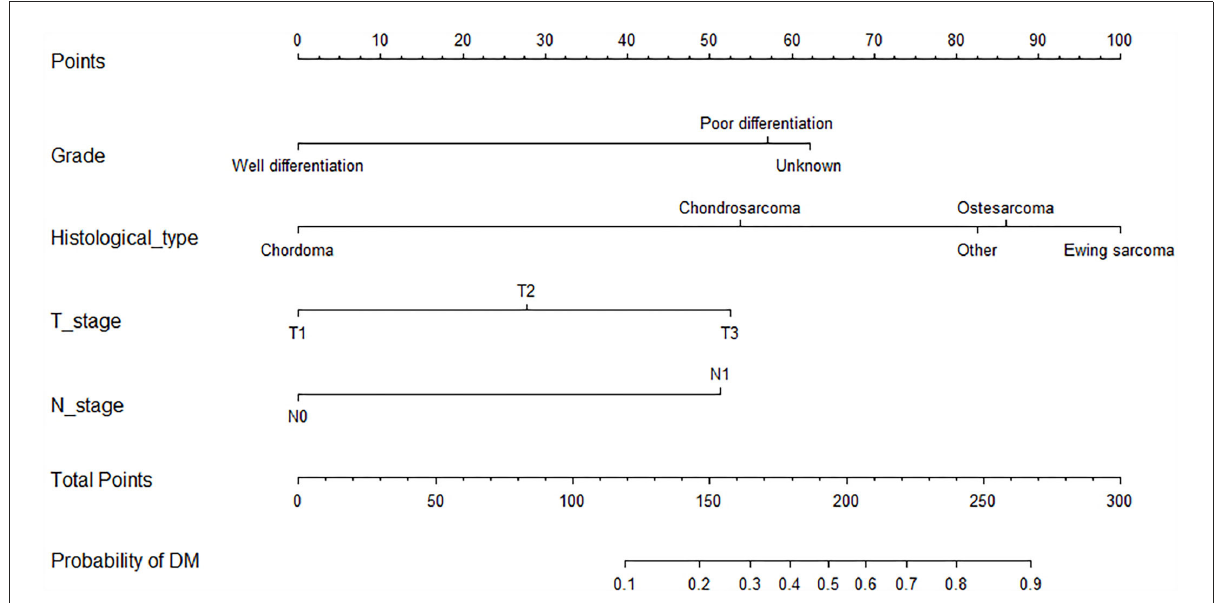
FIGURE3 Diagnostic nomogram for quantifying the probability of DM in patients with POSNs.